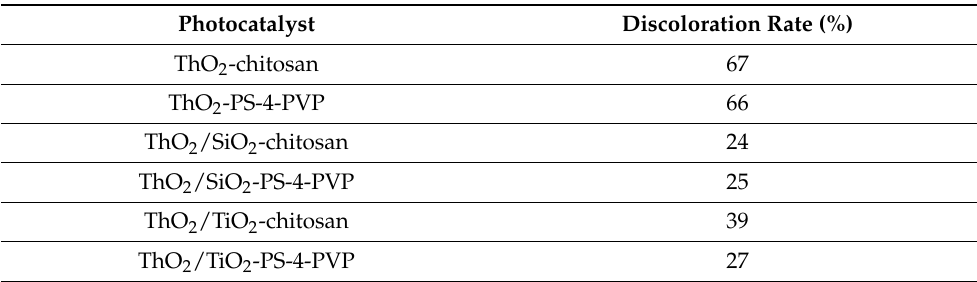
Table 5. Photocatalytic efficiency of the different ThO 2